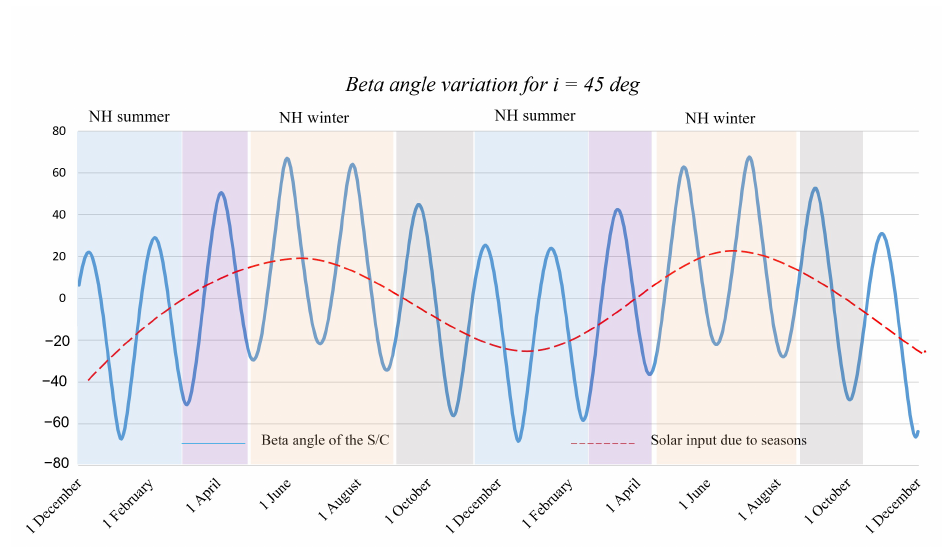
Figure 13. Beta angle